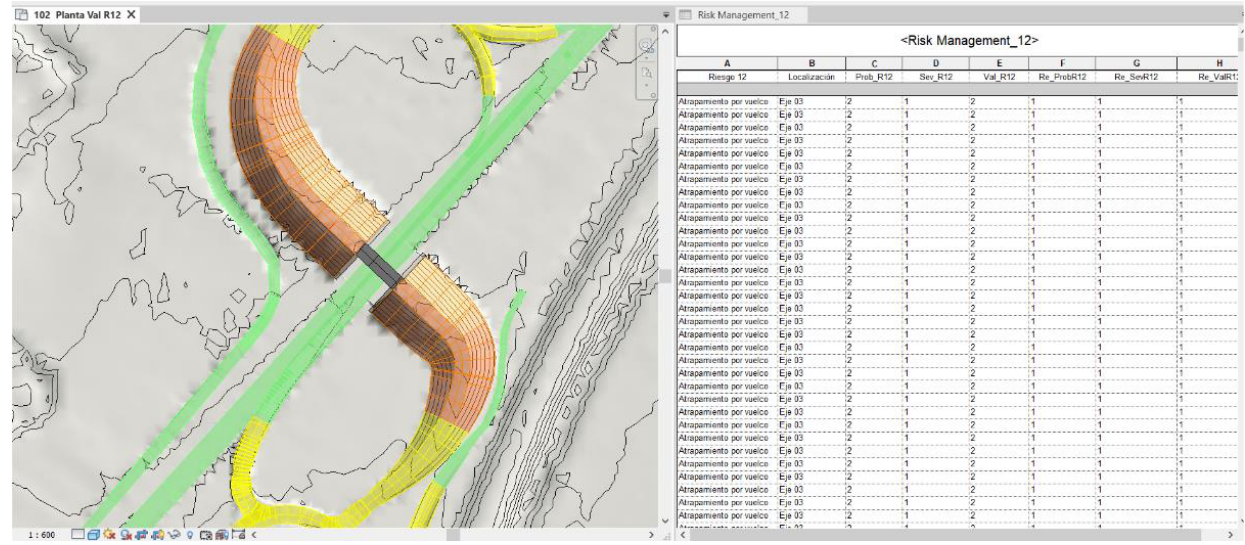
Figure 8. Risk assessment management.